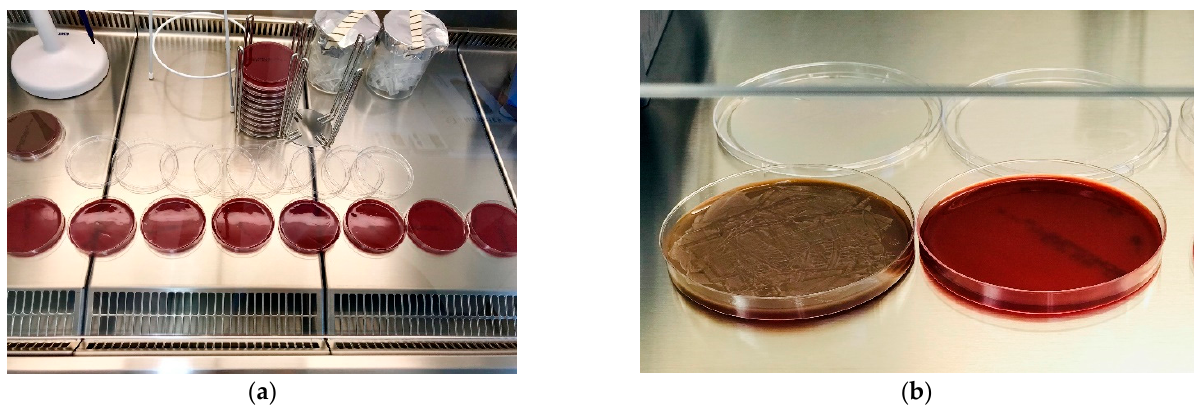
Figure 1. ( a ) Inoculated blood agar plates with specimens from implants 1–8 on test day one. All implants show no signs of bacterial growth similar to negative control. Inoculated blood agar plates with positive control (left) and negative control (right). ( b ) Positive control shows clear signs of bacterial colonization, turbidity and hemolysis, whereas negative control shows no signs of bacterial growth. Table 1. Bacterial exit out of the system. Mean DNA amounts in mg/mL of the implant specimens in comparison to mean positive and mean negative control on all test days measured by the qrt-PCR amplification results for positive controls ( n = 4—four amplification values per positive control), negative controls ( n = 4—four amplification values per positive control) and implant specimens ( n = 16—two amplification values per implant).